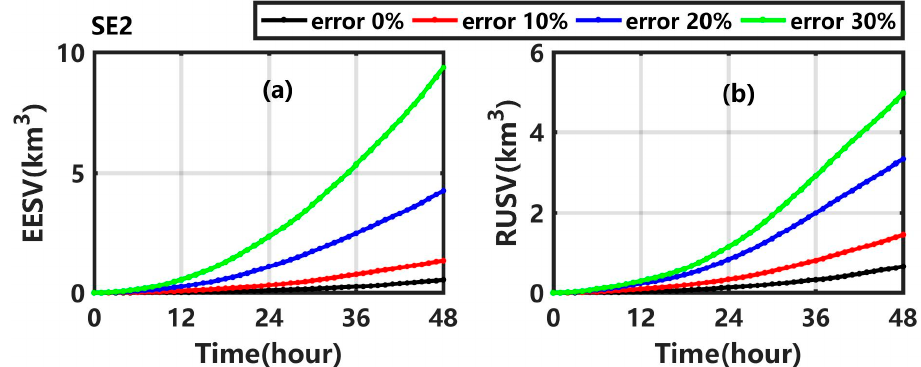
Figure 10. ( a ) EESV and ( b ) RUSV in Exp1 (black line), SE2_1 (red line), SE2_2 (blue line), and SE2_3 (green line).